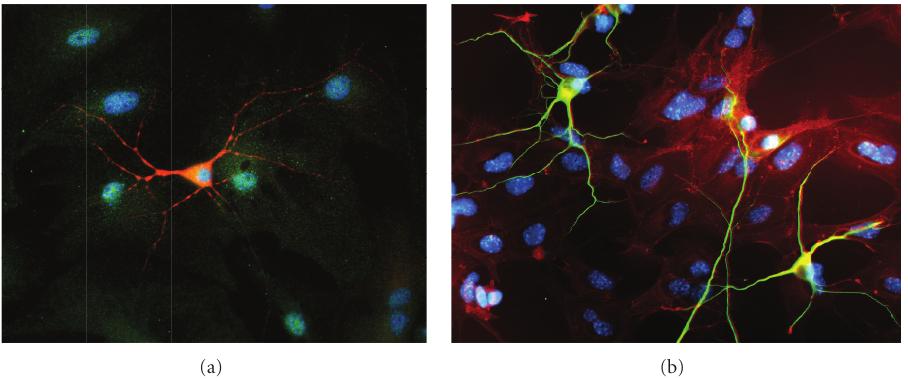
Figure 2: Examples of Fragile X astrocyte-neuron cocultures. (a) FMR1 WT astrocytes + WT neurons double labeled with MAP-2 (neuron in red) and gephyrin (astrocytes in green); (b) FMR1 KO astrocytes + WT neurons identified with MAP-2 (neurons in green) and GFAP (astrocytes in red); DAPI—nuclei